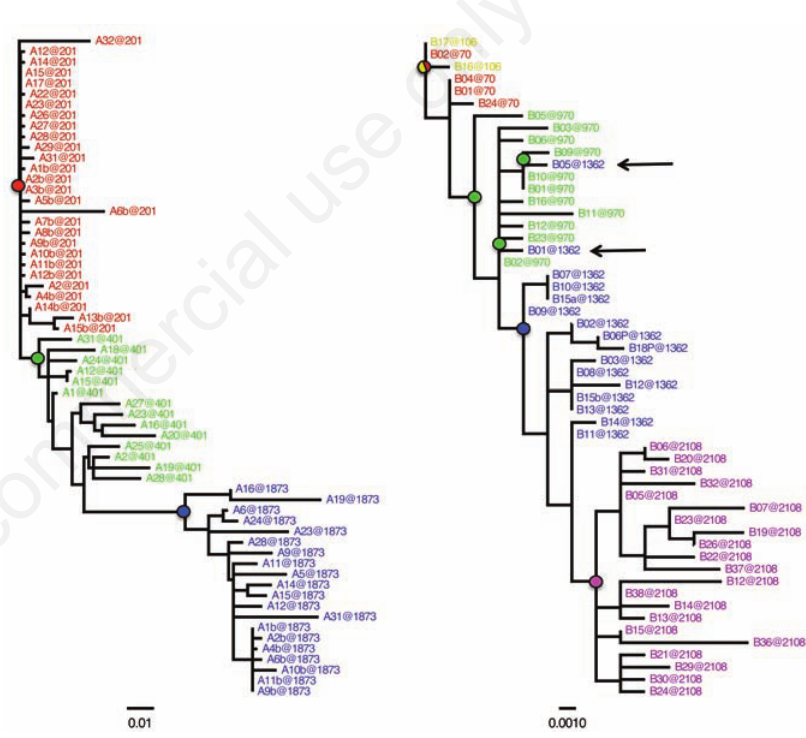
Figure 1. Maximum likelihood genealogies of HIV-1 intra-host sequences sampled over time from two different subjects. The trees were obtained with the HKY+G model. Branch lengths are scaled in nucleotide substitutions per site according to the bar at the bottom of each tree. The number after the @ sign in the sequence label indicates the sampling time in days post infection. Sequence names from different time points are displayed in different colors for clarity. The colored circles highlights the internal nodes representing the most recent common ancestor of the viral population sampled at a given time point. The root was inferred by choosing the rooted topology that resulted in the best linear regression between branch lengths and sampling times. The tree for subject S4 (left) includes a subset of env gp120 V1V3 sequences described in Salemi et al . 36 (2007) from a pediatric patient infected through mother to child transmission. The tree for subject P5 (right) includes a subset of gag p24 sequences described in Norstrom et al. 44 (2012) from a patient carrying the HLA-B*5701 allele with low risk of disease progression. Sequences sampled at a later time point clustering with sequences sampled earlier are indicated by arrows and may reveal archival genomes from viral reservoirs. The alignments used in the analysis are available from the author upon